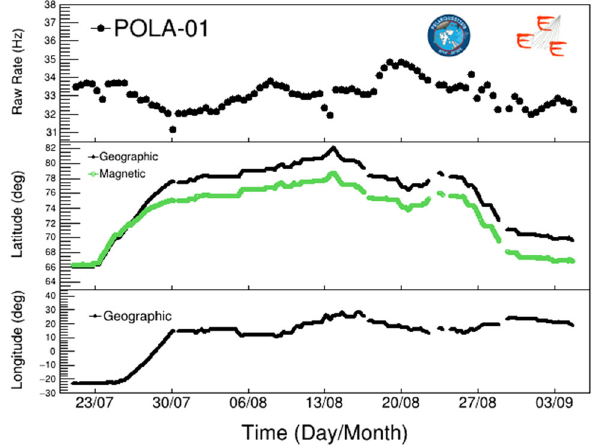
Fig. 16 POLA-01 raw rate (top panel), geographic and magnetic lat- itude (middle panel) and longitude (bottom panel) as a funtion of the time since July 22, 2018, till the end of its trip in Tromsø